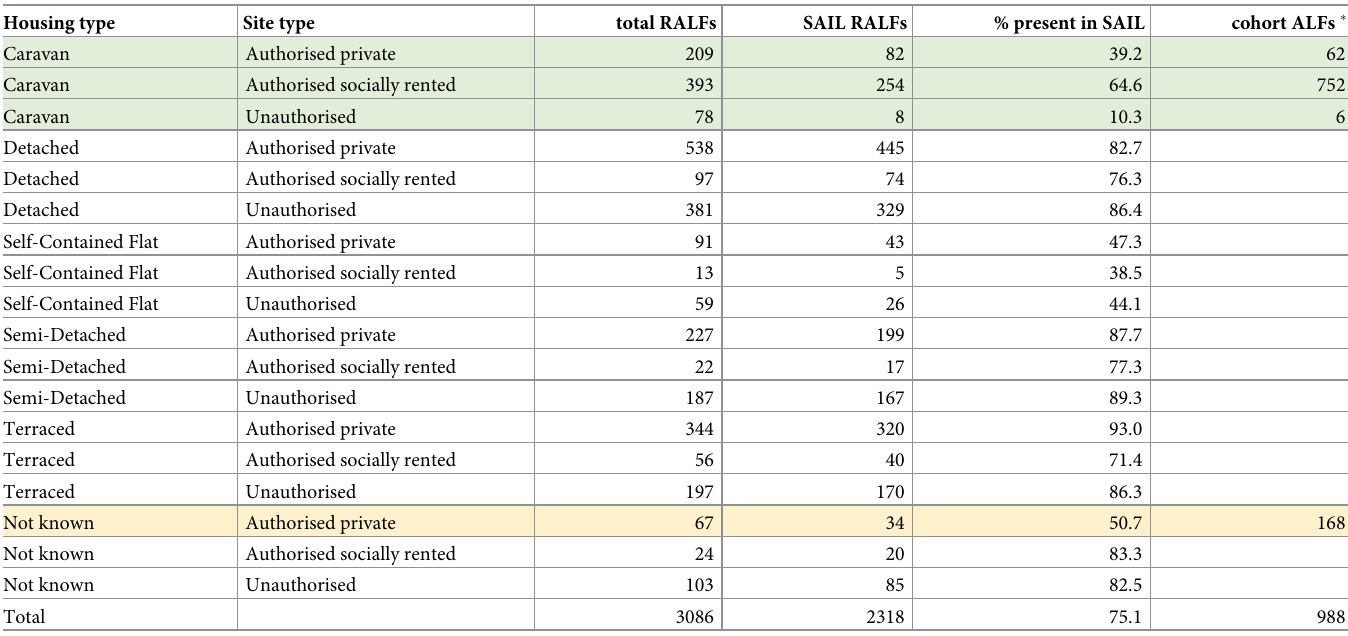
Table 2. Gypsy and Traveller site RALFs present in SAIL.